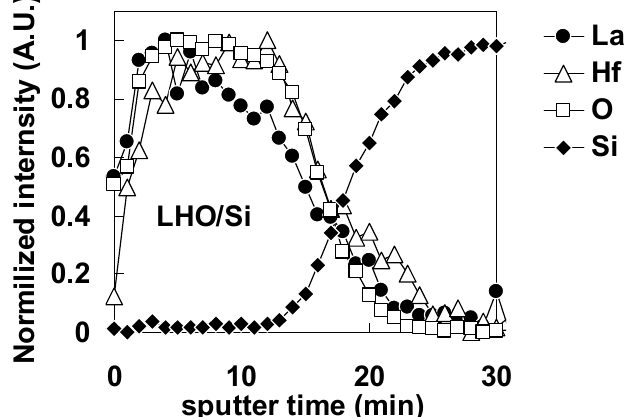
Figure 25. Auger electron spectroscopy (AES) depth profile for the LHO/Si stack. The vertical axis is normalized to show the sharpness of the interface more clearly.